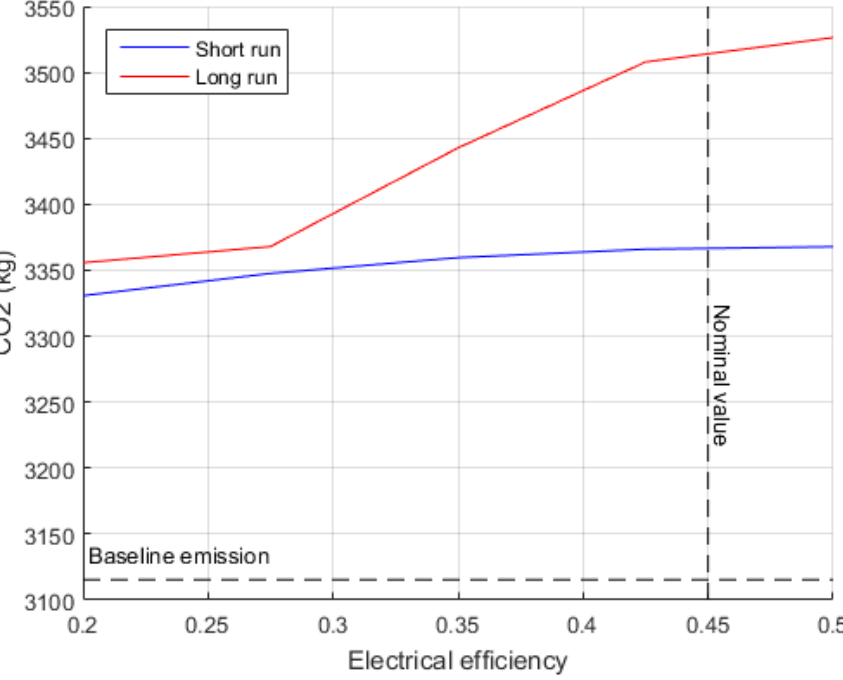
Figure 16. Influence of fuel cell design on environmental performance.